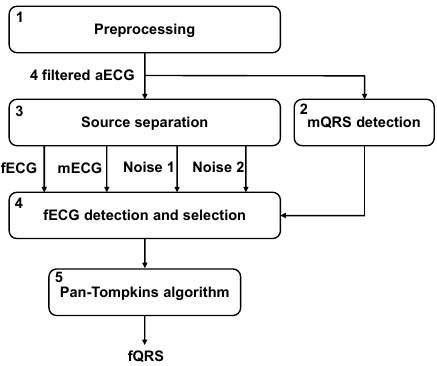
Figure 3. fQRS detection process: ( 1 ) Preprocessing step with notch filter, high pass filter and low pass filter utilized; ( 2 ) The Pan-Tompkins algorithms applied for mQRS detection used to create a template mECG and for channel selection in independent component analysis (ICA) method; ( 3 ) Source separation includes different approaches (TS, ICA and its hybrid). For ICA and the hybrid method, the extracted signals contain 4 signals (i.e., fECG, mECG and two noise signals; ( 4 ) Using mQRS detection from ( 2 ) as a criterion for fECG selection; ( 5 ) The Pan-Tompkins algorithm applied for fQRS detection.